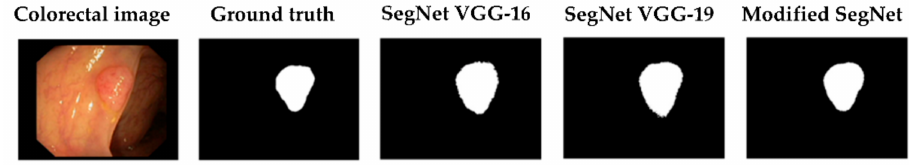
Figure A5. Segmentation results for a colorectal image from SegNet VGG-16, SegNet VGG-19, and our modified SegNet, with the ground truth for the colorectal image as a